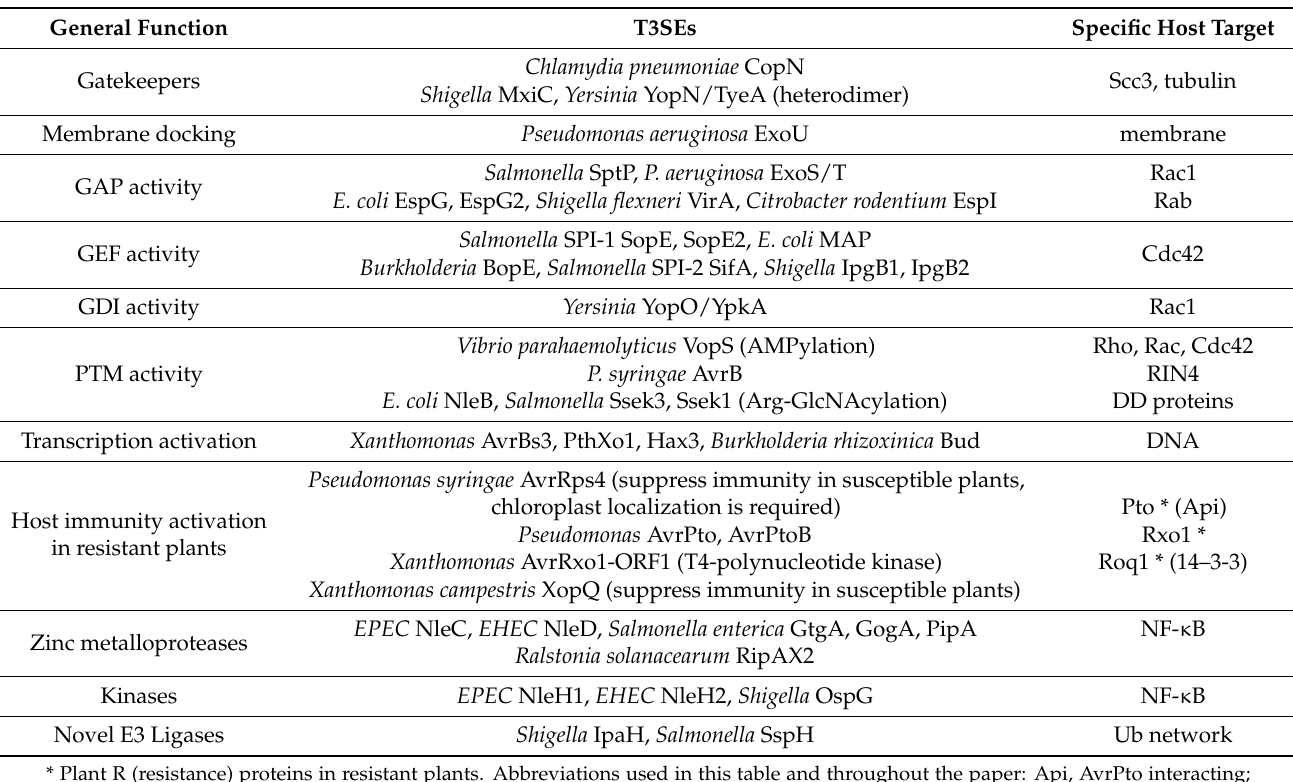
Table 1. List of the α -helical T3S effectors discussed in this paper.